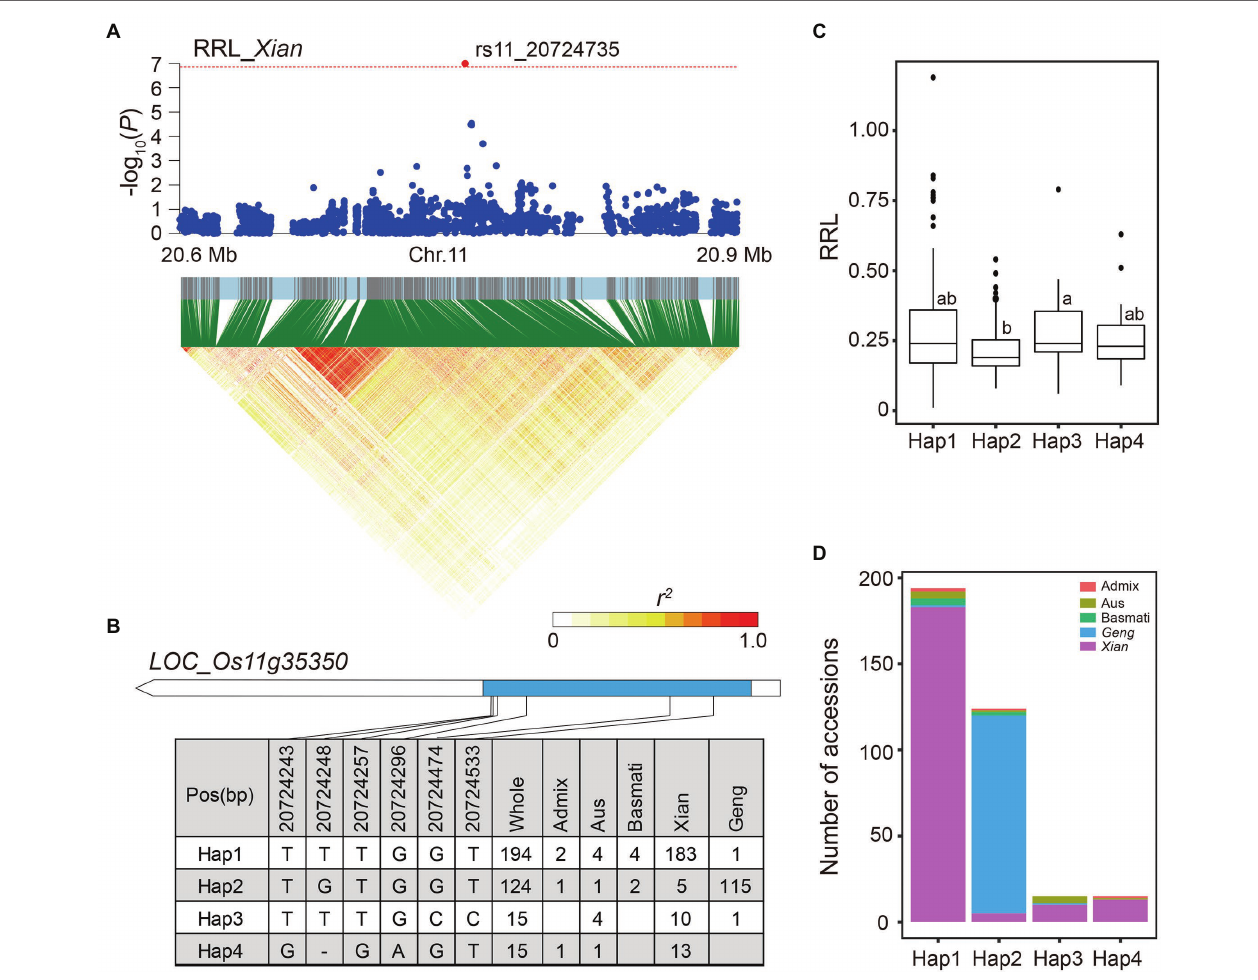
FIGURE 7 | Candidate gene analysis of locus 82 on chromosome 11. (A) Local Manhattan plot (top) and LD heat map (bottom) of locus 82 for RRL in the Xian subpopulation. The red dot indicates the lead SNP rs11_20724735 and the position of candidate gene LOC_Os11g35350 . (B) CDS-haplotypes of LOC_Os11g35350 . (C) The distribution of RRL in the whole population for the four haplotypes of LOC_Os11g35350 . Different letters above each boxplot indicate significant differences among haplotypes according to Duncan’s multiple range post-hoc test ( p < 0.05). (D) Frequency of four haplotypes of LOC_Os11g35350 in subpopulations.